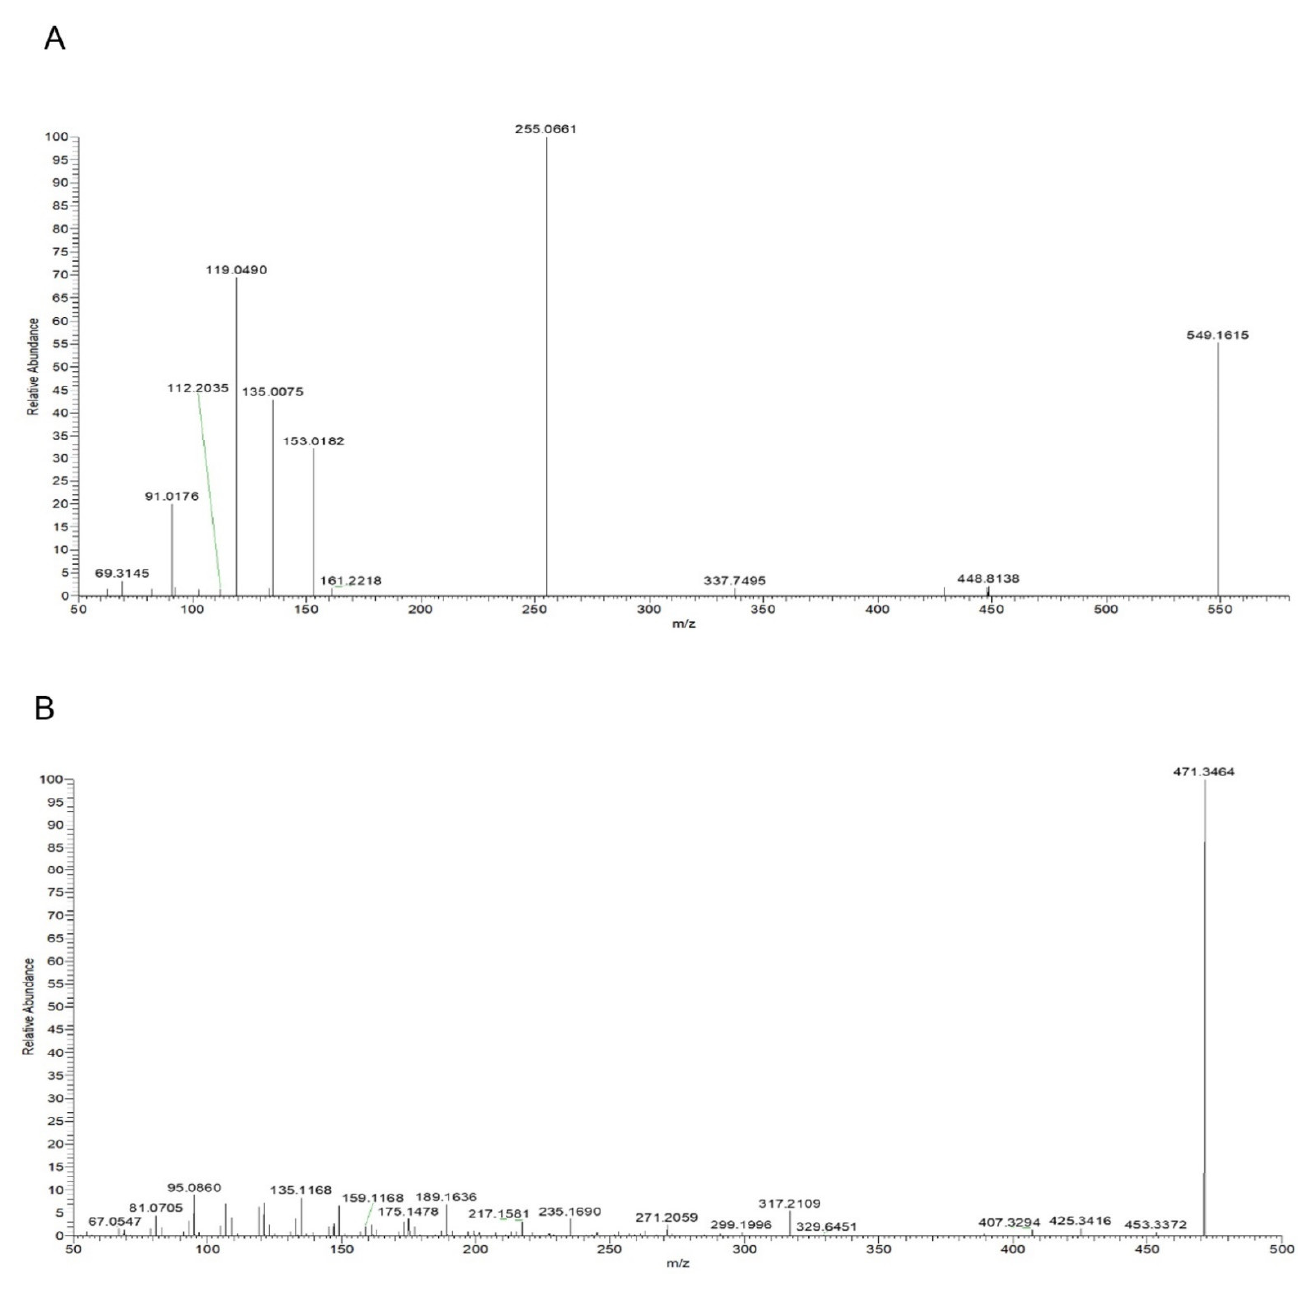
Figure 5. Mass spectra: ( A ) Liquiritin apioside in negative ion mode; ( B ) glycyrrhetinic Acid in positive ion mode.